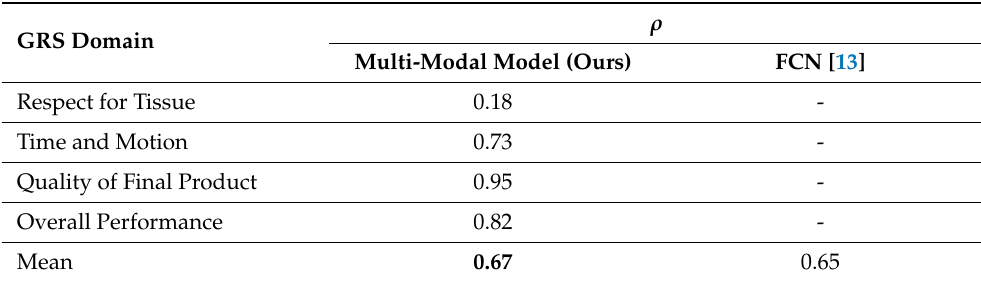
Table 8. Spearman Correlation Coefficient between the multi-modal AI predictions and the ground truth. Best performing model on the JIGSAWS dataset included as reference [13].